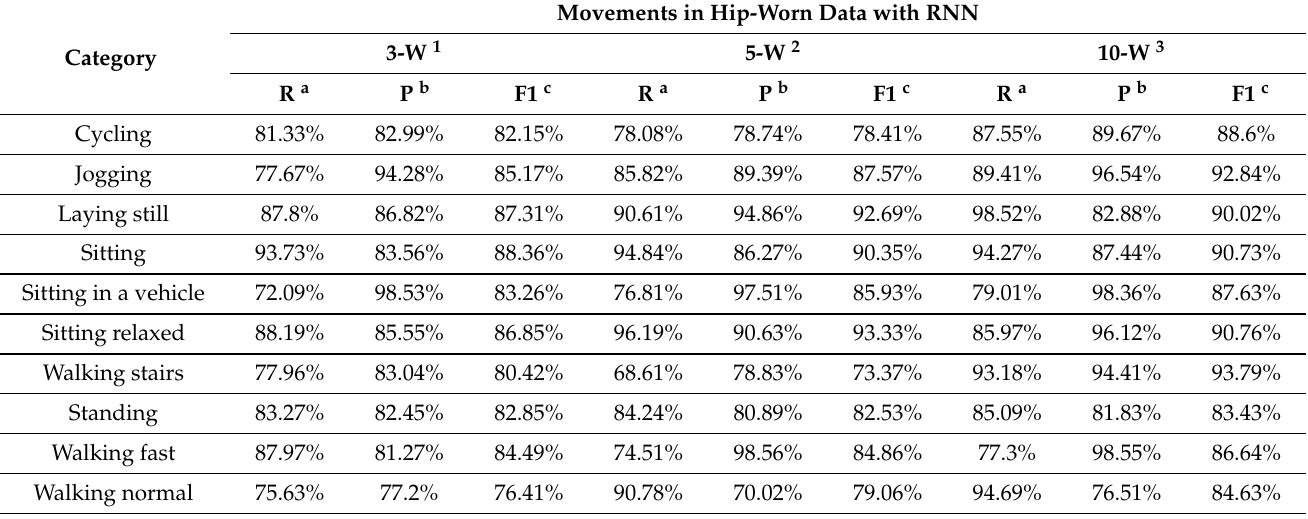
Table 4. Best result of 3, 5, 10-s window of hip-worn data using RNN. Movements in Hip-Worn Data with RNN 3-W 1 5-W 2 10-W Category